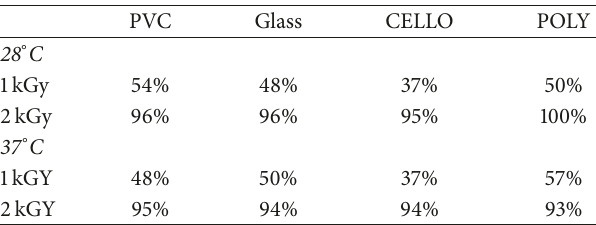
Table2:Inhibition(%)of Salmonella Hadarbiofilmformation,after gamma radiation exposure.